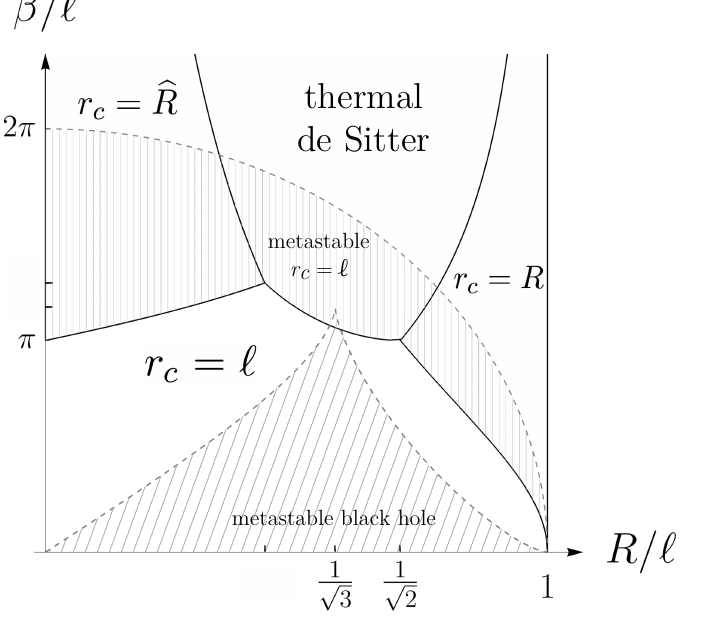
Figure 10. Phase diagram for combined thermal dS, b- and c-horizon configurations, allowing for b ↔ c transitions, with boundary size R and inverse temperature β . In the region with diagonal lines the small and large black hole solutions exist. (The coordinates ( R/‘, β/‘ ) of the two triple q √ √ √ p points are ( 3 − 5 / 2 , π ( 5 + 1) / 2) and (1 / 2 , π ) , and the tip of the metastable black hole √ √ region is at (1 / 3 , 2 π/ 3) , where the minimal temperature Nariai